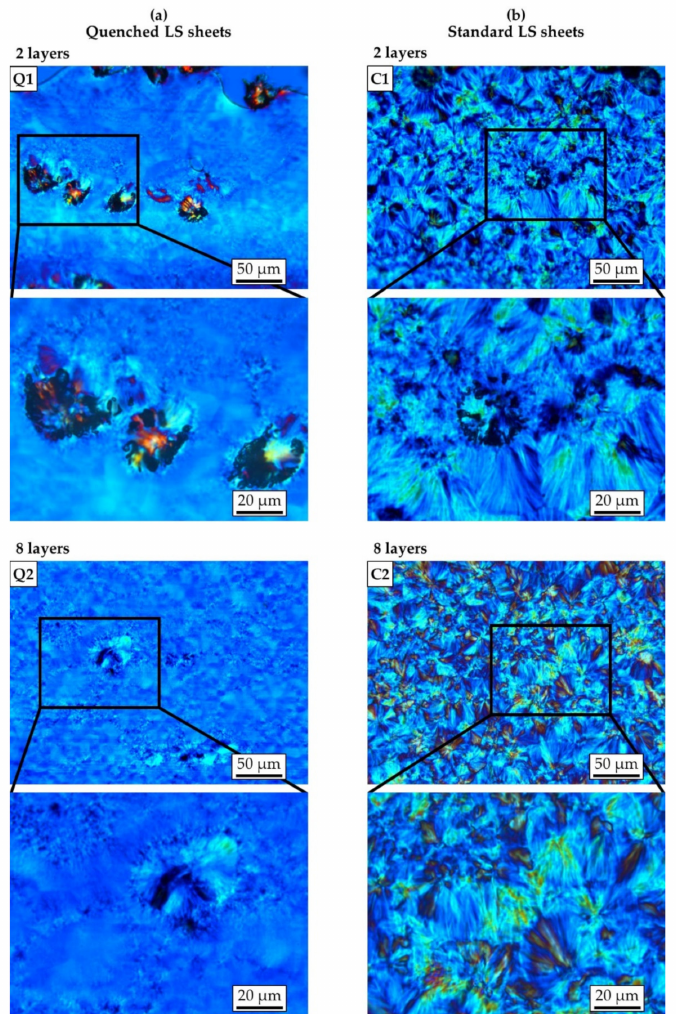
Figure 3. Light microscopy images of thin sections showing the inner area of ( a ) quenched and ( b ) standard laser-sintered (LS) polyamide 12 sheets generated with two and eight layers. Magnified images of the rectangular sections in the first and third row are shown in the second and fourth